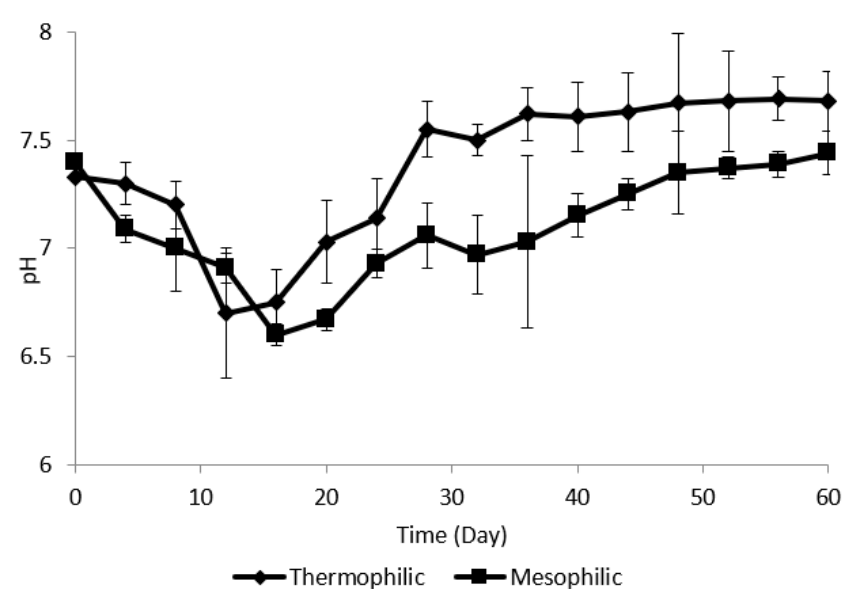
Figure 6. pH range of thermophilic and mesophilic effluents during the acclimatization period. Notes: error bars show standard deviation of means (n = 3).